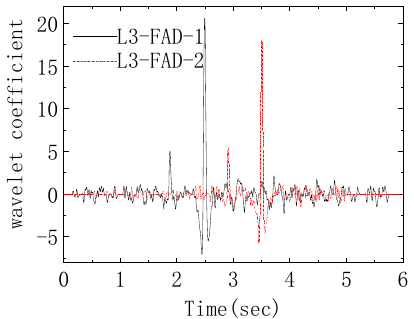
Figure 12. Wavelet coefficient functions for Lane 3 FAD signals (both with db2 at scale of 8). The time stamps for the L3-FAD-1 signal peaks are 1.880 s and 2.490 s for the first and second peaks respectively. The corresponding respective time stamps for L3-FAD-2 are 2.905 s and 3.495 s.